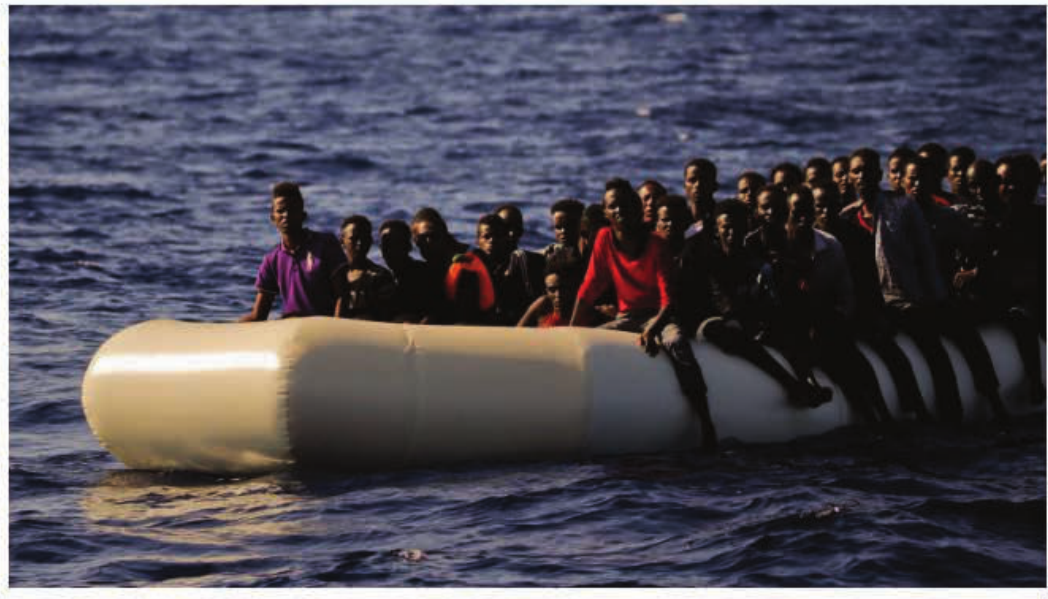
Figure 3: Migrants fleeing Libya on a dinghy wait to be rescued in the Mediterranean Sea. Credit:AP (SMH), http://www.smh. com.au/world/migrant-crisis/counting-the-lost-and-nameless-dead-of-the-mediterranean-20160830-gr504f.html (date of last access: